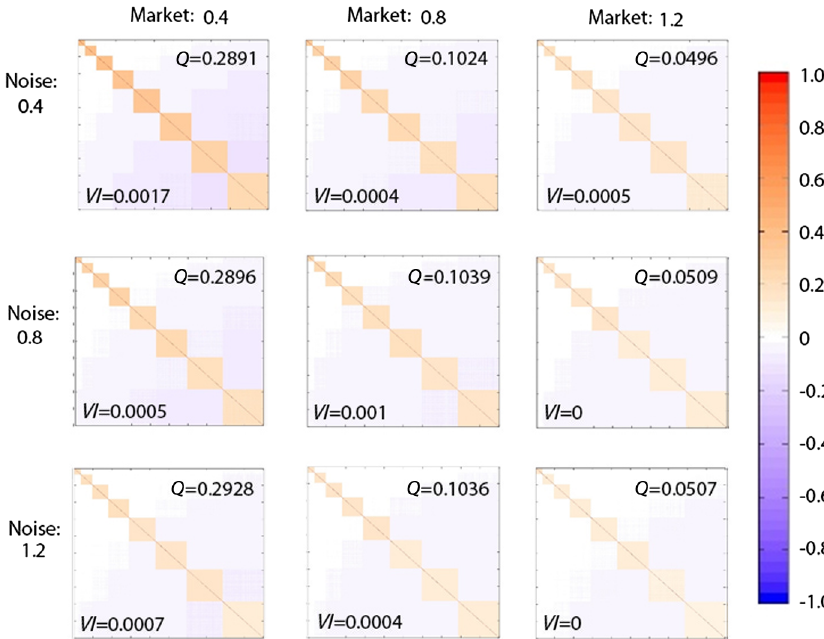
FIG. 4. Performance of our method on nine benchmark sets of correlated time series with varying levels of noise ( ν ) and market-mode ( μ ) components. For each combination of μ and ν , N ¼ 1000 time series of length T ¼ 50000 , partitioned into c ¼ 8 communities (always containing 35, 60, 85, 110, 140, 165, 190, and 215 time series, respectively), were initially generated according to Eq. (42). Then, the 1000 × 1000 correlation matrix C was calculated. The heat maps in this figure show the values of the entries of the filtered matrix C ð g Þ defined in Eq. (17) and obtained by removing the noise and market-mode components from the original correlation matrix. Blocks along the diagonal represent the residual correlations within each community, while off-diagonal blocks show the residual negative cross-correlations among communities. Our method, using the Potts algorithm (see the Appendix) here to maximize the modularity Q 3 ð ~ σ Þ defined in Eq. (35), was always able to correctly identify the target communities, even for values of μ and ν exceeding 1. This is indicated by the value of VI (averaged over 10 runs of the community detection algorithm) calculated between the “ true ” and the detected partition in each benchmark. The average (over multiple runs) maximum modularity value Q in each